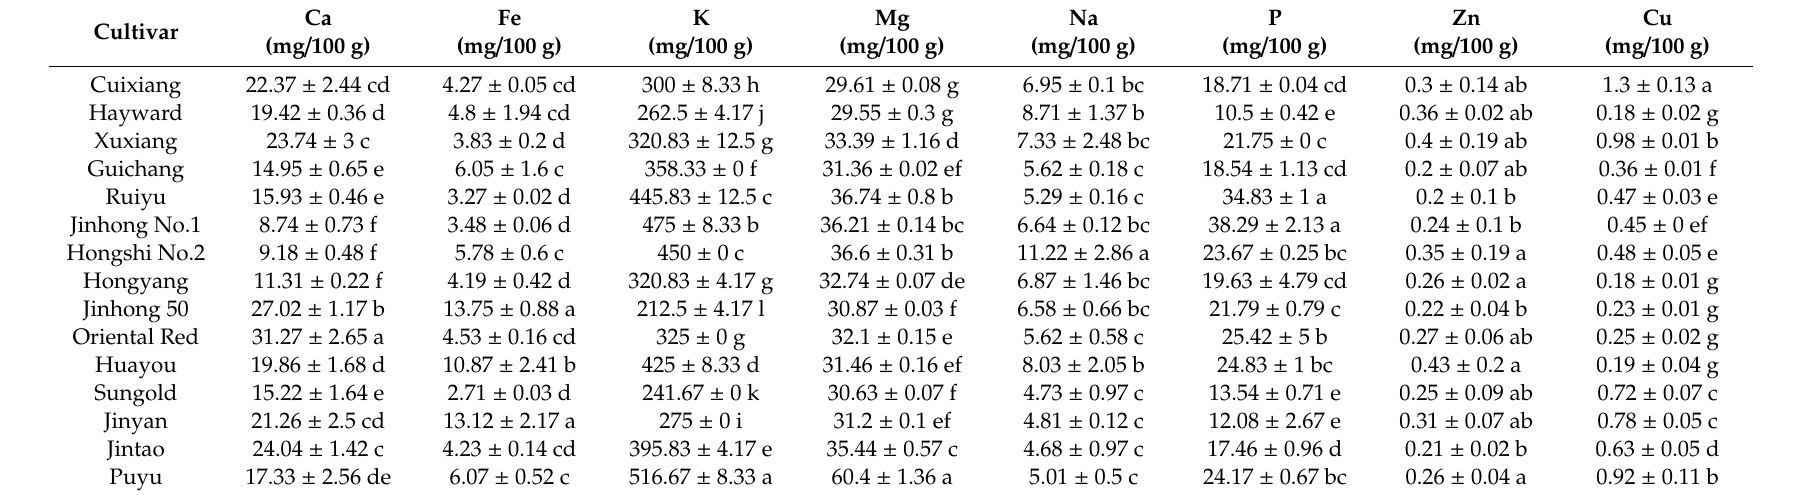
Table 5. 8 kinds of trace elements in 15 kiwifruit